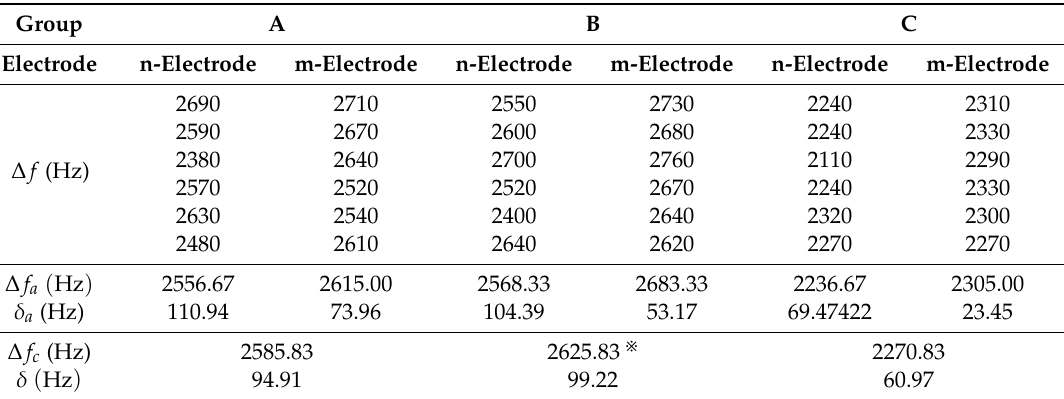
Table 1. Experimental